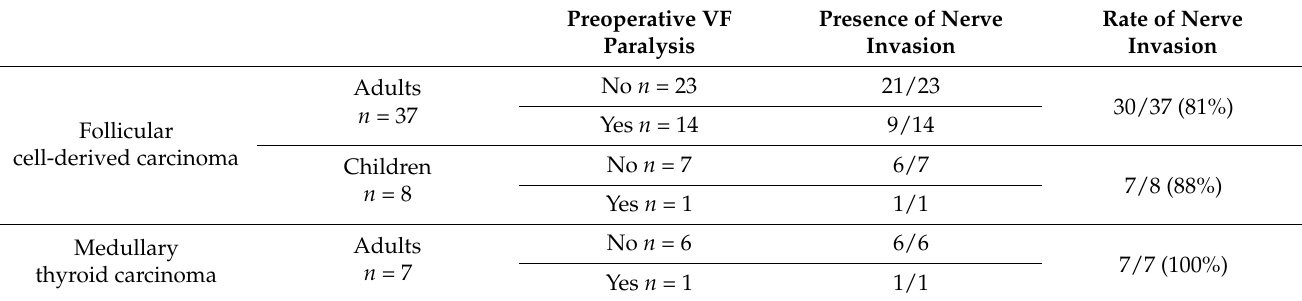
Table 1. Relationship between preoperative vocal fold (VF) paralysis and histopathological nerve